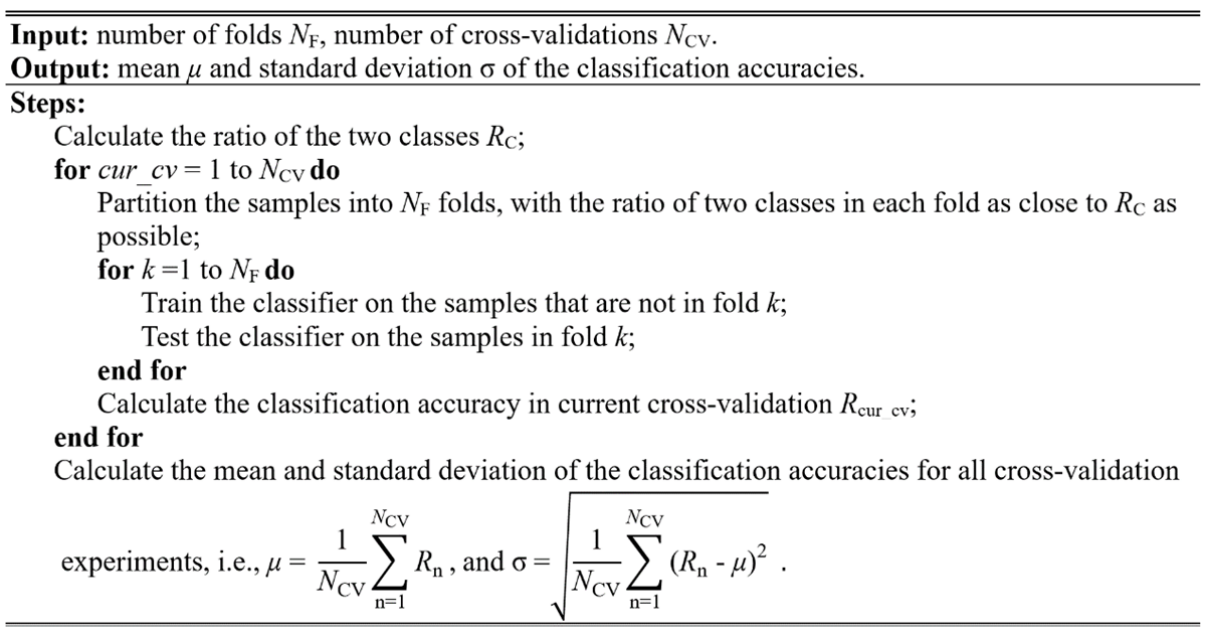
Figure 4. Algorithm of the stratified cross-validation with multiple random